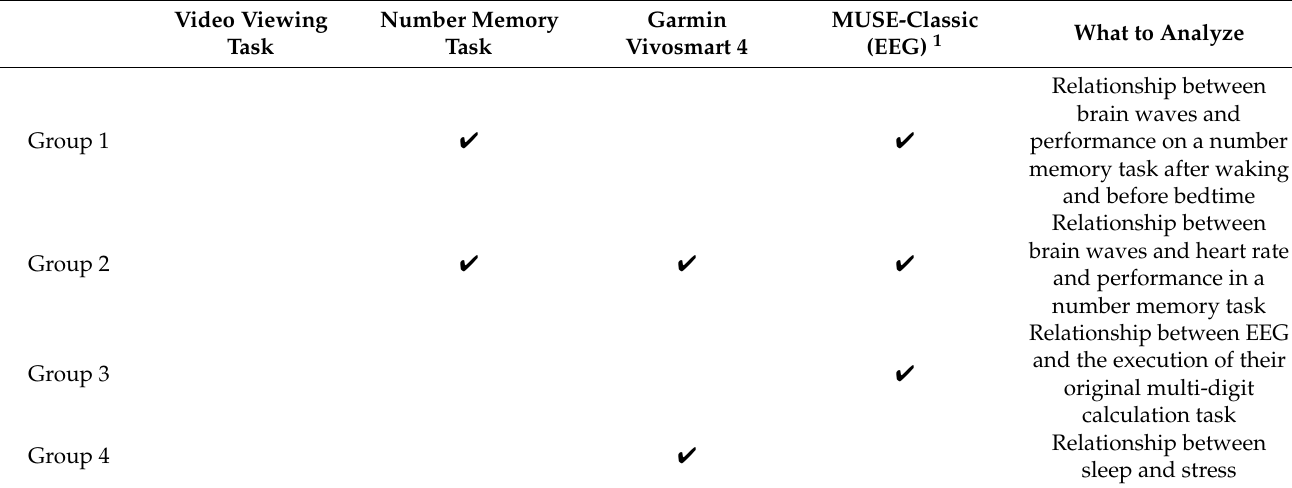
Table 1. Presentations by student groups and types of data used.